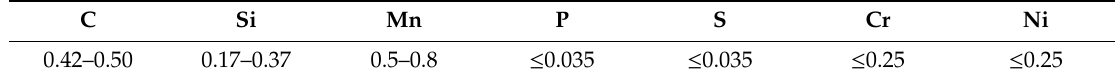
Table 1. Steel composition for the casting experiments (Unit, wt %).